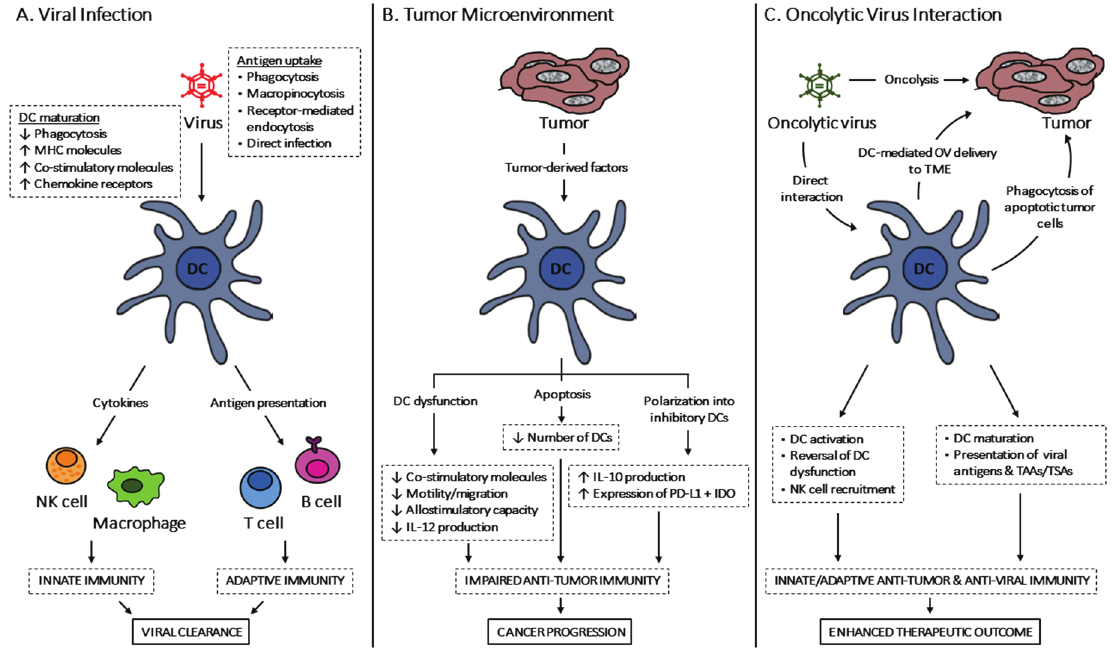
Figure 1. Multifunctional dendritic cells in the generation of anti-viral and anti-tumor immunity. ( A ) Upon recognition of viral infections, DCs acquire viral antigens through various mechanisms and become activated into a matured state that is more adept at antigen presentation. These DCs induce innate immune responses, in cells such as NK cells and macrophages, through the secretion of cytokines and chemokines, and also establish an anti-viral state in cells via type I IFNs. The activated DCs also prime antigen-specific T cells for the induction of adaptive immunity by presenting viral antigens in MHC molecules, along with co-stimulatory molecules and inflammatory cytokines. Overall, DCs are critical in the establishment of anti-viral immunity that eradicates the invading viral pathogen; ( B ) In the immunosuppressive TME, abnormal DC number and function hinder the generation of anti-tumor immunity. Tumor-derived factors, such as gangliosides and TGF- β , can prevent DC maturation and migration, which impede the activation of allogeneic tumor-specific T cells. DCs can also be polarized to an inhibitory state with increased PD-L1 and IDO expression, triggering T cell tolerance. Furthermore, tumor-induced apoptosis of tumor-associated, as well as circulating, DCs contribute to tumor immune evasion, thereby posing a challenge to anti-tumor immune responses; ( C ) During therapeutic OV administration, the interaction between DCs and OVs can enhance the anti-tumor effects of each constituent. While OVs can directly induce lysis of cancer cells and anti-tumor immunity, these effects can be enhanced through DC-mediated delivery of OVs to the TME, which aids OVs in avoiding anti-viral mechanisms. In return, OVs can trigger DC maturation and overturn impaired antigen presentation, thus overcoming tumor-associated immunosuppression. Moreover, OV-induced apoptosis of cancer cells releases tumor antigens, which can be captured and presented by DCs for the activation of tumor-specific T cells.